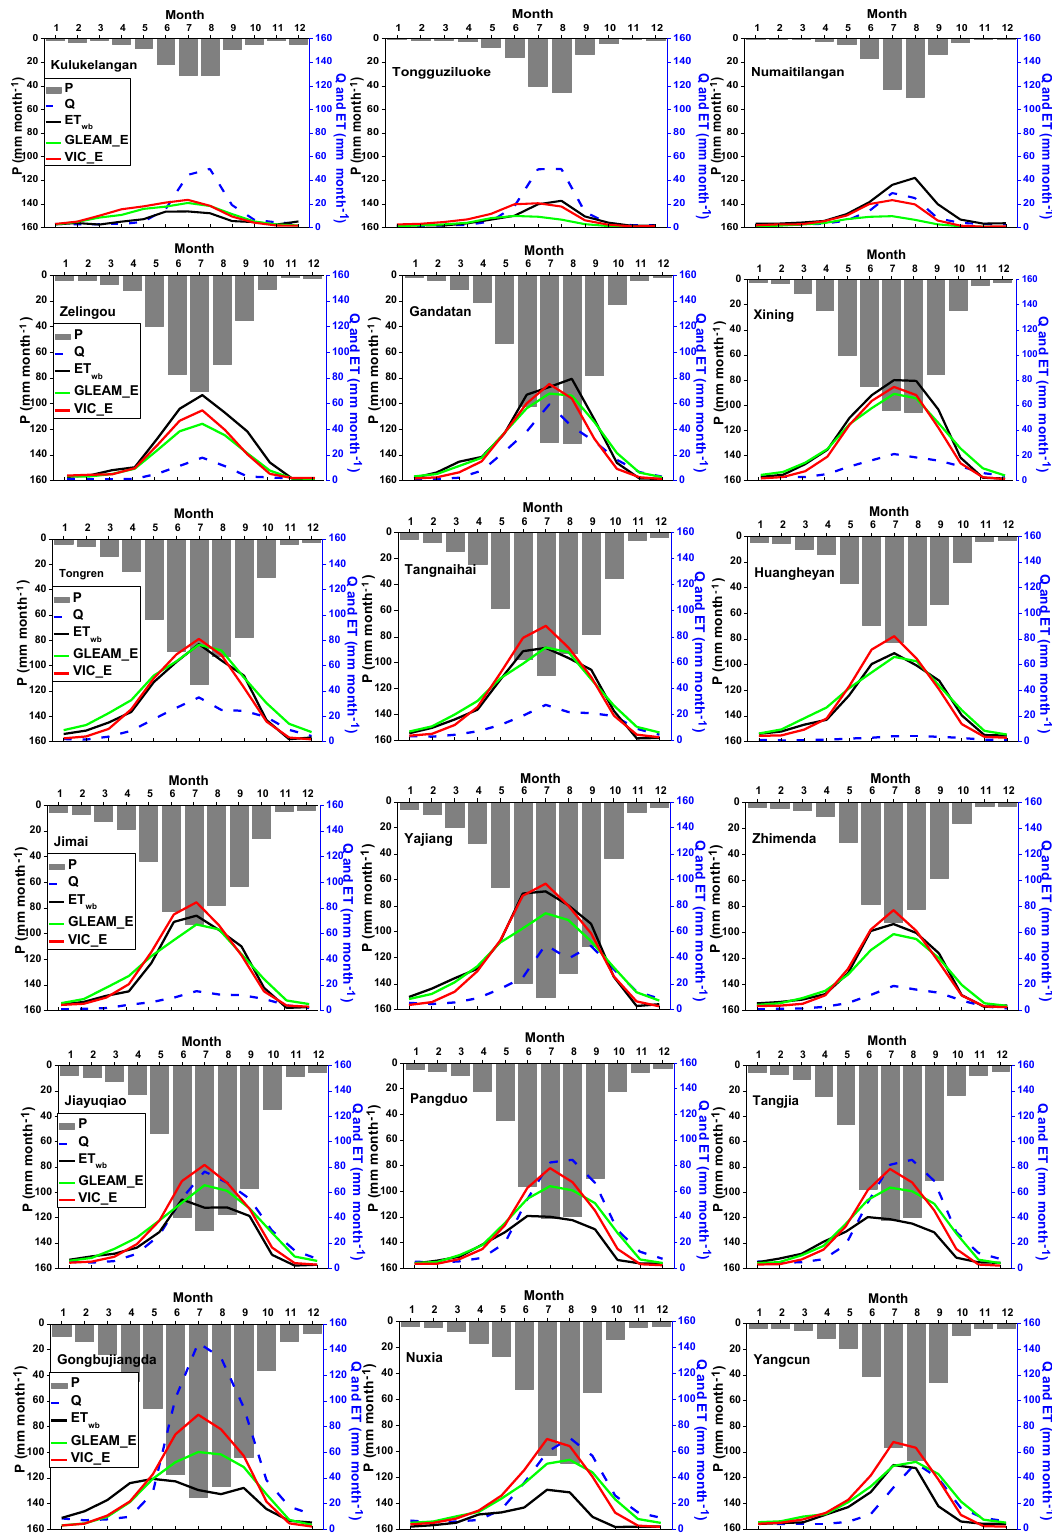
Figure 5. Seasonal cycles (1982–2011) of water budget components in westerlies-dominated (row 1), east-Asian-monsoon-dominated (rows 2–4) and Indian-monsoon-dominated (rows 5–6) TP